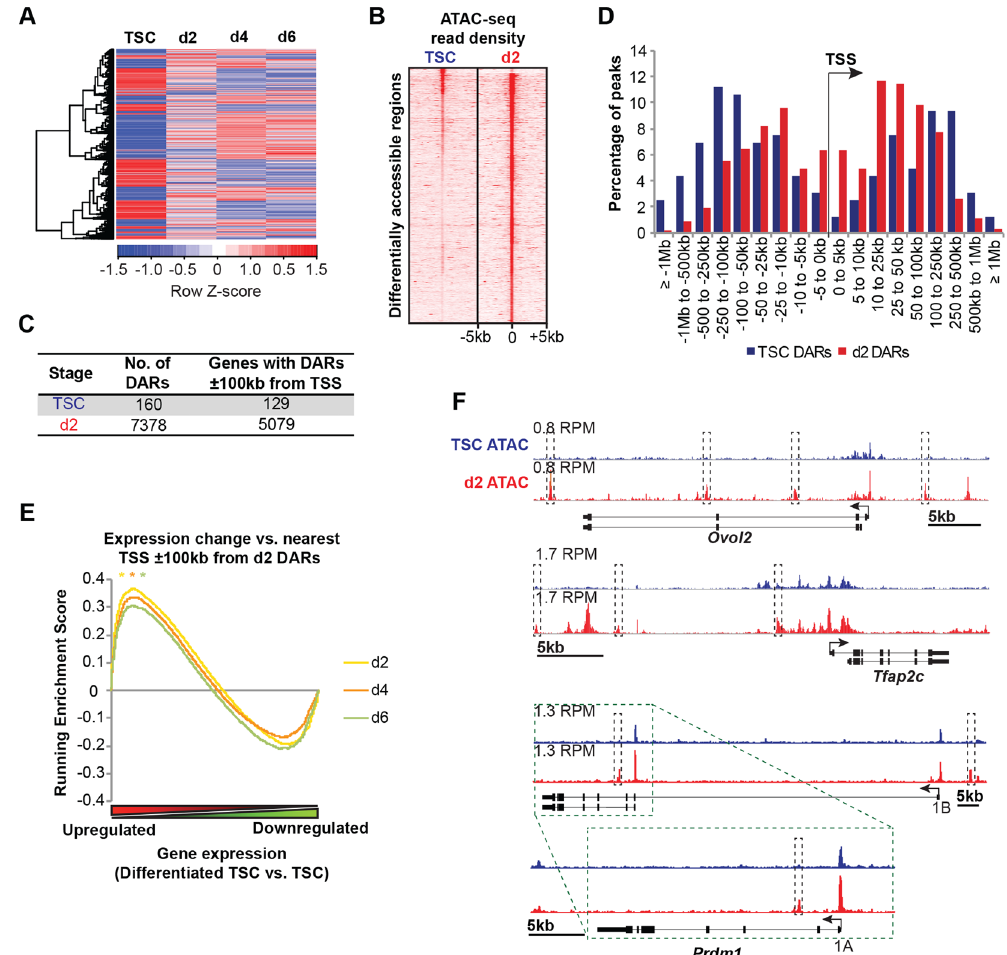
Figure 2. Increased chromatin accessibility leads to activated gene expression during trophoblast differentiation. ( A ) Microarray heatmap of genes differentially expressed during trophoblast differentiation. In contrast to our previous study where we used these data to identify genes differentially expressed between wild type and Prdm1 mutant trophoblasts 20 , here we present gene expression changes during wild type TSC differentiation. ( B ) Heatmap of ATAC-seq read densities at high-confidence TSC and d2 DARs as indicated in B. ( C ) Defined differentially accessible regions (DARs) and corresponding nearest TSSs ± 100 kb. ( D ) Distribution of DARs relative to the nearest TSS defined by GREAT 84 . TSC DARs are significantly further from TSSs than d2 DARs – P = 6.0 × 10 − 8 , two-tailed homoscedastic t-test. ( E ) Gene Set Enrichment Analysis comparing genes with d2 DARs (nearest TSS ± 100 kb) and microarray gene expression changes during TSC differentiation. * P ≤ 1 × 10 − 3 . ( F ) TSC and d2 ATAC-seq peaks at the Ovol2 , Tfap2c and Prdm1 loci. RPM = Reads per million. Identified d2 DARs are indicated in grey boxes. Distinct annotated Prdm1 promoters are